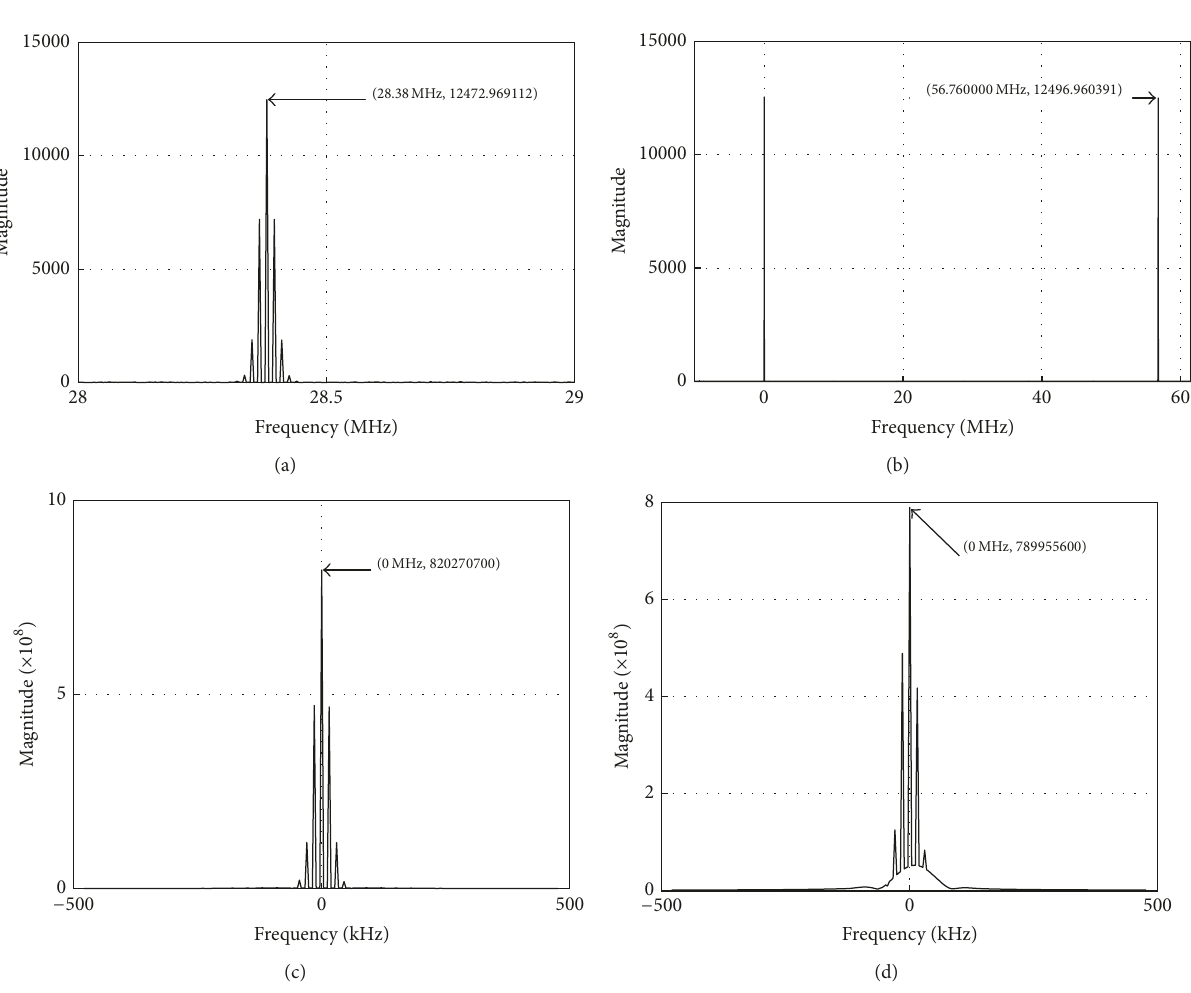
Figure 17: Results of DDC core and FM demodulator. (a) FM-modulated signal generated in Matlab, (b) magnitude spectrum of mixer, (c) magnitude spectrum of CIC-1, and (d) magnitude spectrum of a C-FIR